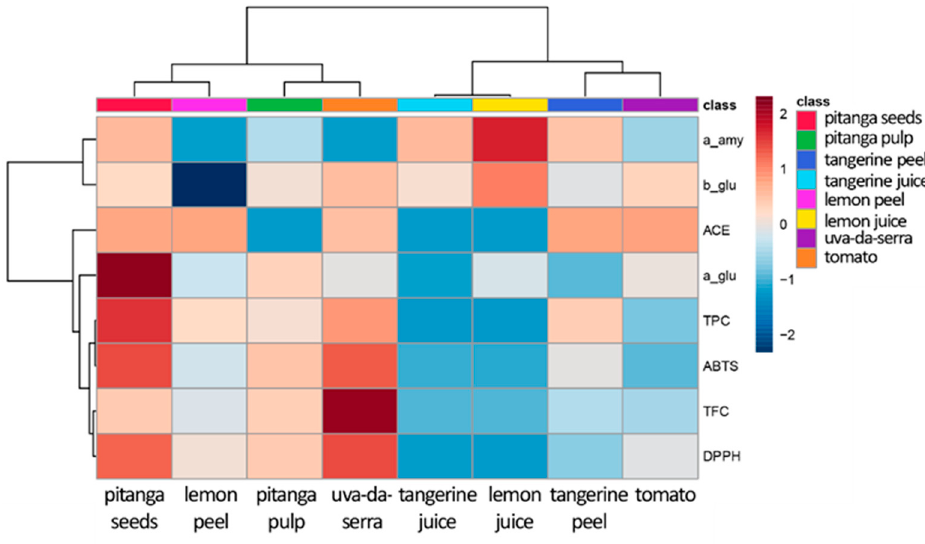
Figure 5. Correlation heatmap to evaluate the putative contribution of the phenolics and flavonoids present in the samples extracts to the TAC and key enzymes inhibition. The different assays were performed as described in Materials and Methods. Legend: a_amy— α‐ amylase, a_glu— α‐ glucosidase, b_glu— β‐ glucosidase, ABTS—2,29 ‐ azinobis ‐ (3 ‐ ethylbenzothiazoline ‐ 6 ‐ sulfonic acid) radical cation assay, ACE—angiotensin ‐ converting enzyme, DPPH—2,2 ‐ diphenyl ‐ 1